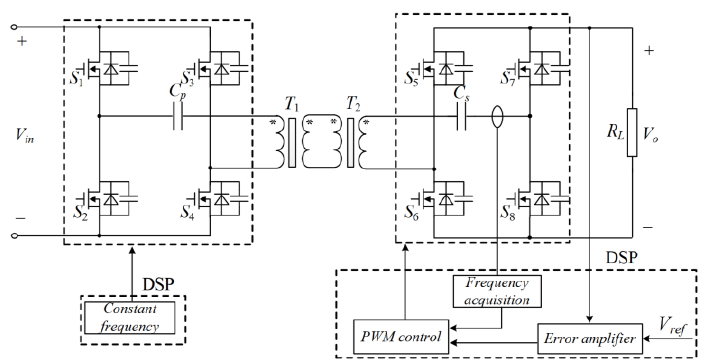
Figure 3. Dual active S – S IPTS with P-CF+S-PWM control strategy [17].